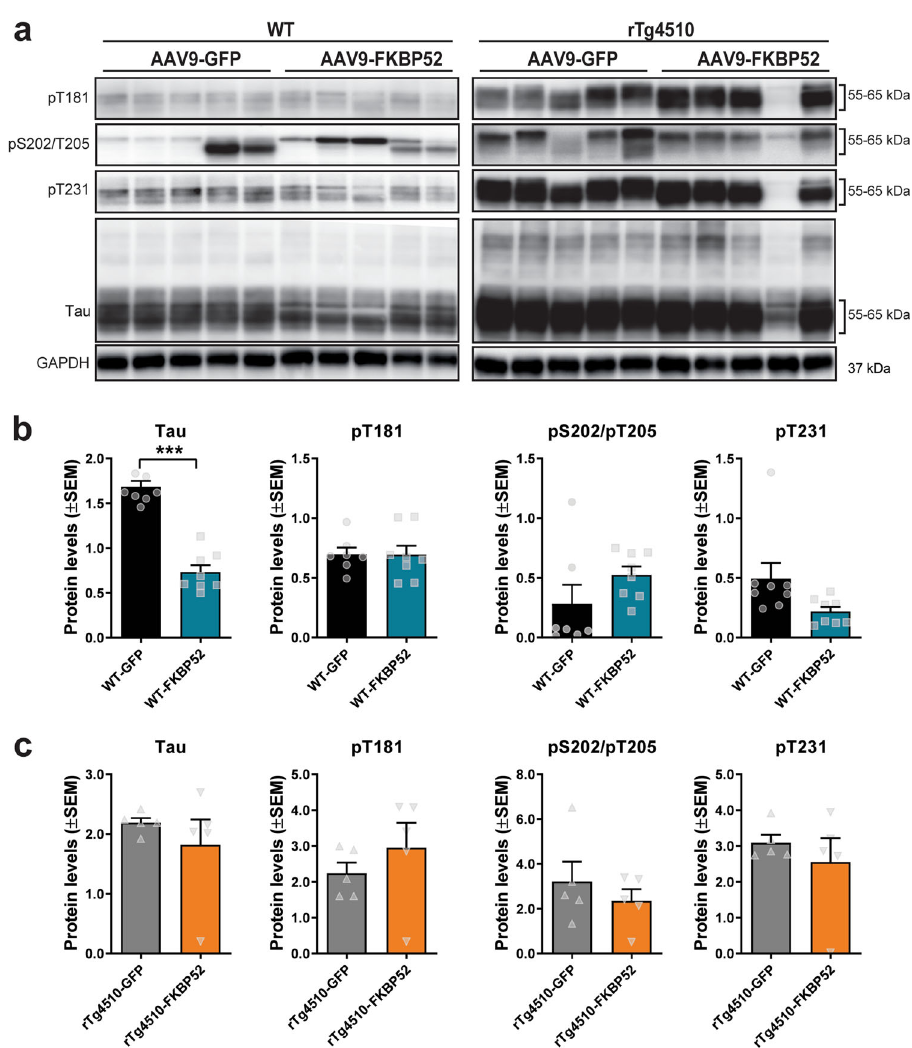
Fig. 7 FKBP52 overexpression differently affects tau levels in WT and rTg4510 mice. a Representative Western blot analysis of soluble fraction from hippocampal tissue of WT and rTg4510 mice expressing either AAV9-GFP or AAV9-FKBP52. b , c Quanti fi cation of Western blots of soluble total (amino acids 1 – 150), pT181, pS202/pT205 (AT8), and pT231 (AT180) tau in WT and rTg4510 mice. All proteins were normalized to GAPDH. Results are were analyzed by unpaired t test and represented as the standard error of the mean (±SEM). WT-GFP ( n = 8), WT-FKBP52 ( n = 8), rTg4510-GFP ( n = 5), rTg4510-FKBP52 ( n = 5). kDa kilodalton, AAV9 adeno-associated virus serotype 9, GFP green fl uorescent protein, WT wild-type, GAPDH Glyceraldehyde 3-phosphate